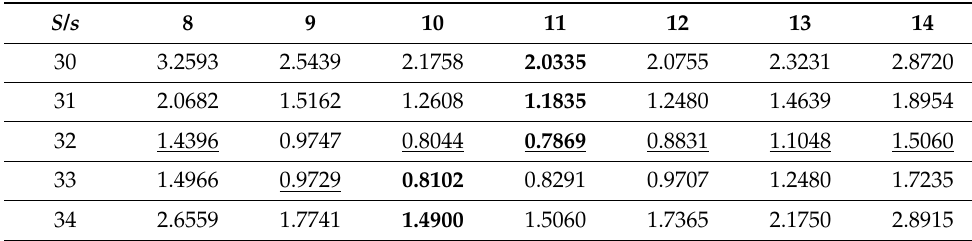
Table 1. Total expected cost rate interms of S and s